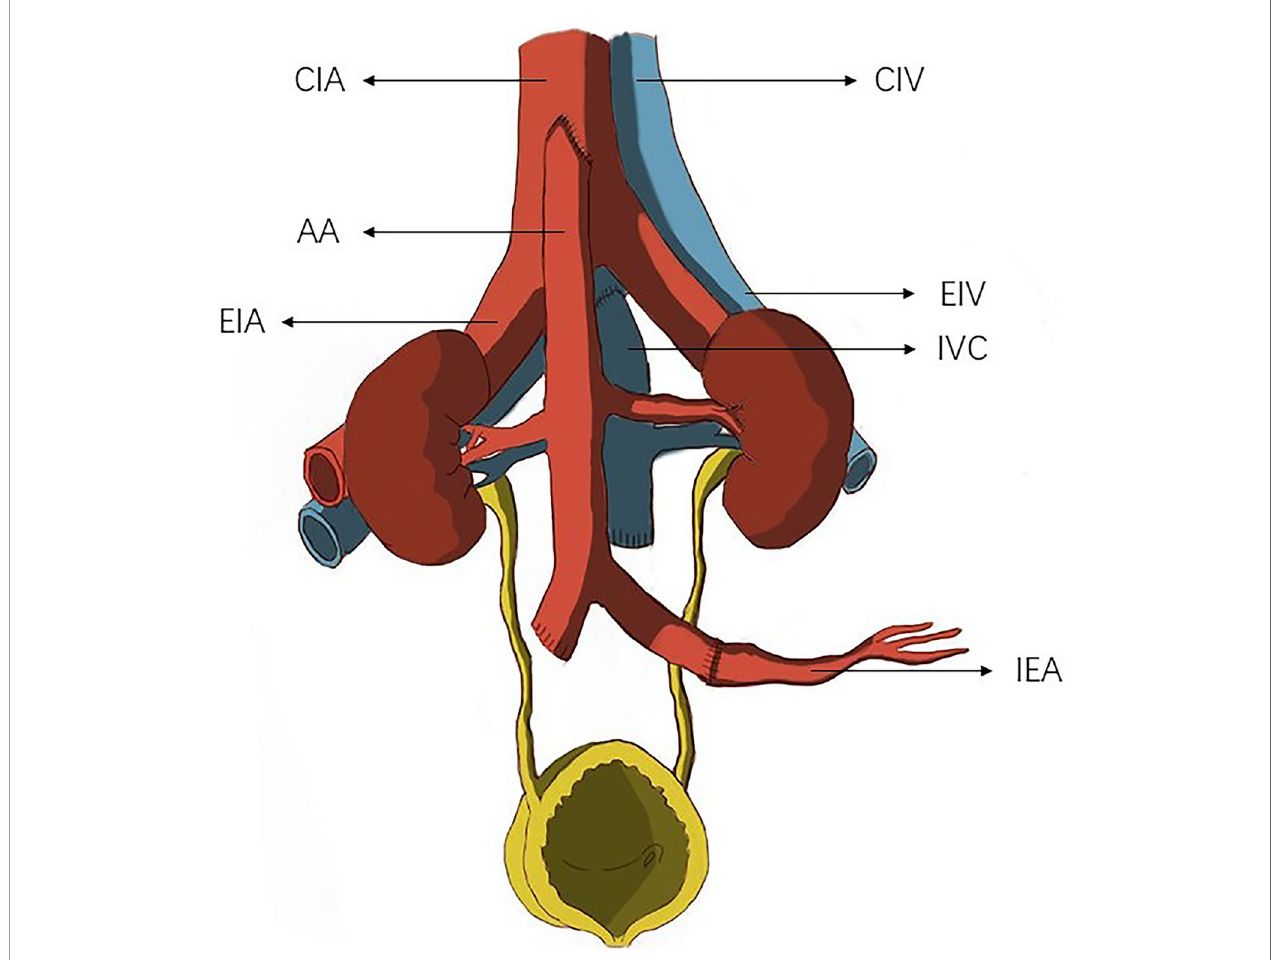
FIGURE 2 | The donor common iliac artery or external iliac artery was anastomosed to the recipient inferior epigastric artery to establish an out fl ow tract. CIA, common iliac. artery; AA, abdominal aorta; EIA, external iliac artery; CIV, common iliac vein; EIV, external iliac vein; IVC, inferior vena cava; IEA, inferior epigastric